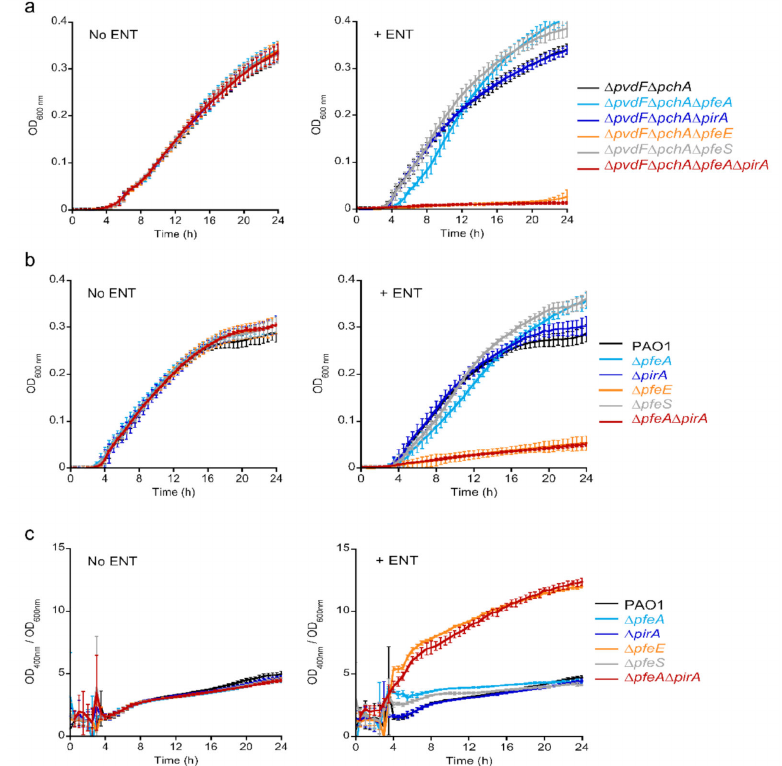
Figure 3. Growth of various P. aeruginosa mutants with or without 10 µ M ENT in the CAA medium. In ( a ), the strains used are unable to produce the siderophores PVD and PCH: ∆ pvdF ∆ pchA strain and its corresponding ∆ pvdF ∆ pchA ∆ pfeA , ∆ pvdF ∆ pchA ∆ pirA , ∆ pvdF ∆ pchA ∆ pfeA ∆ pirA , ∆ pvdF ∆ pchA ∆ pfeE and ∆ pvdF ∆ pchA ∆ pfeS mutants. In ( b ), the strains are able to produce PVD and PCH; the pfeA , pirA , pfeE and pfeS mutations were carried out in PAO1. In ( a , b ), the strains were grown in the iron- restricted CAA medium with or without 10 µ M ENT at 30 ◦ C. Growth was followed by monitoring optical density (OD) at 600 nm. ( c ) PVD production during growth of PAO1, ∆ pfeA , ∆ pirA , ∆ pfeE , ∆ pfeS , and ∆ pfeA ∆ pirA strains in CAA medium at 30 ◦ C with or without 10 µ M ENT. PVD production was followed by monitoring the characteristic absorbance at 400 nm of this siderophore [37]. Data are presented as the ratio between the OD at 400 nm and the OD at 600 nm. All data, panels ( a – c ), are the means of three independent